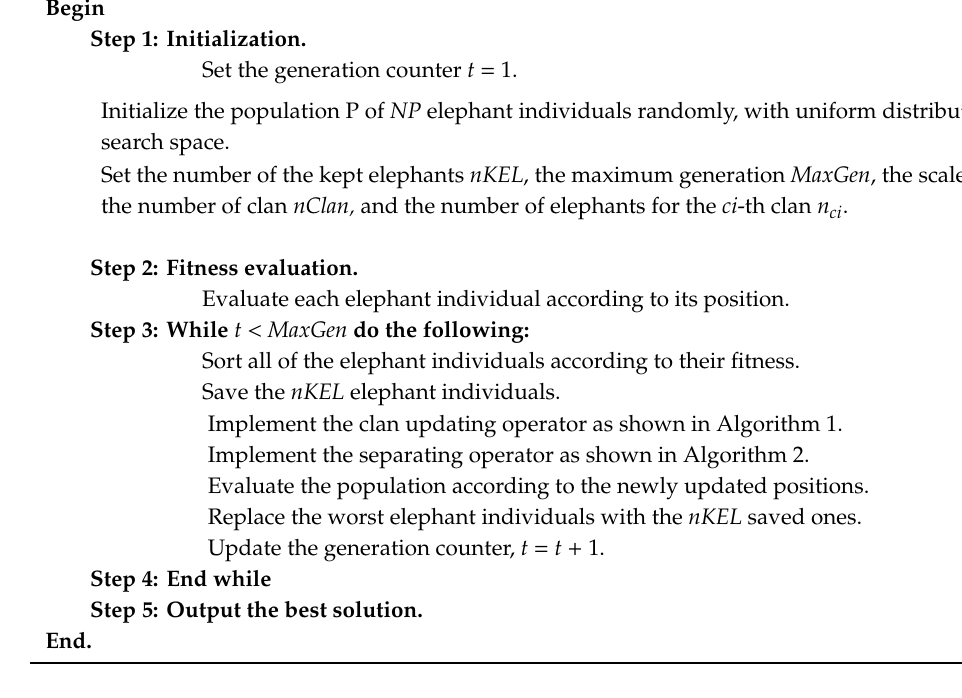
Algorithm 3: Elephant Herd Optimization (EHO)